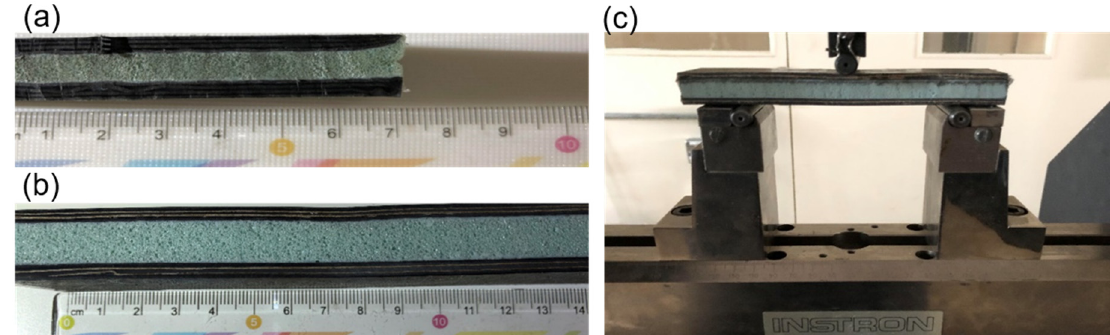
Figure 3. ( a ) Pure RCF skin sample 1; ( b ) hybrid skin sample 2; ( c ) three-point bending test of samples.